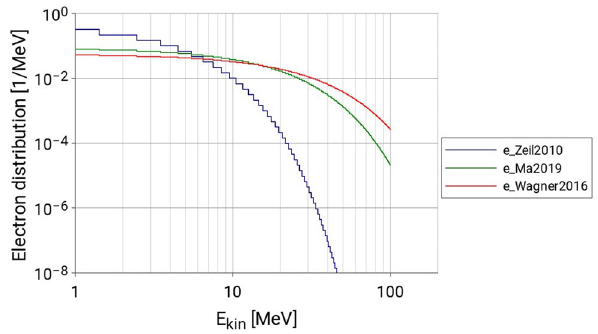
Figure 5. Relative electron spectra used as input parameter for the LION-Geant4